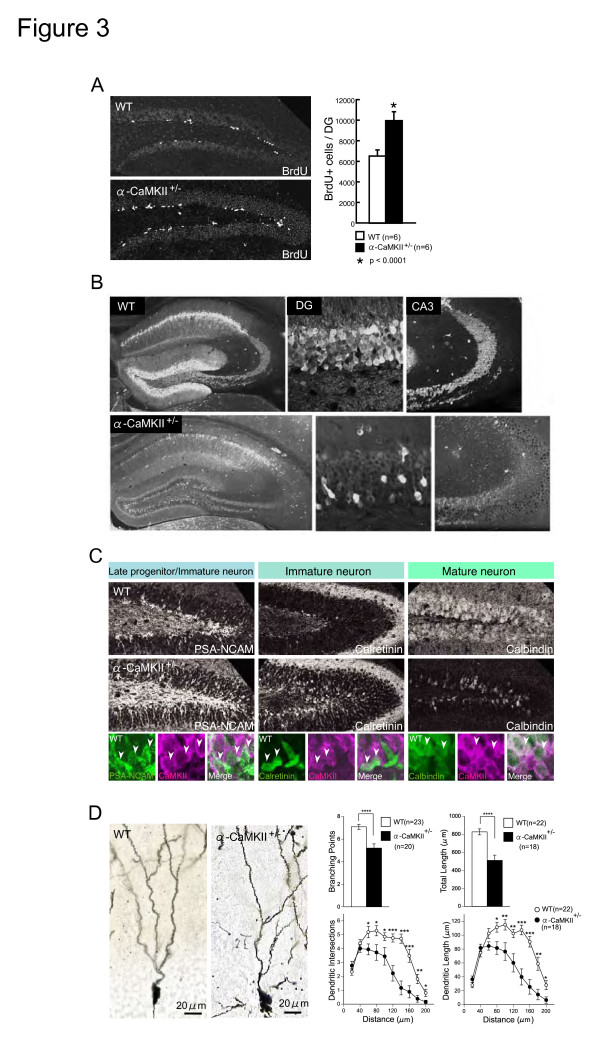
Immature DG of Alpha-CaMKII+/- Mice. (A) The number of BrdU-positive cells in the subgranular zone of the DG is increased in the alpha-CaMKII +/- mice at 7 weeks old, as observed 1 d after BrdU administration. The number of BrdU-positive cells within the DG was 52.8% higher (p = 0.00001) in the alpha-CaMKII +/- mice than in the wild-type mice. (B) In alpha-CaMKII+/- mice, the number of cells expressing calbindin (a mature-neuron marker) was decreased. (C) In alpha-CaMKII+/- mice, the number of cells expressing PSA-NCAM (a late-progenitor and immature-neuron marker) and calretinin (an immature-neuron marker) was markedly increased. CaMKII was co-expressed in a subset of PSA-NCAM-, calretinin-, and calbindin-expressing cells, indicated by the white arrowheads. For the analysis of expression of markers related to neurogenesis and differentiation, at least five mice were examined in each group. (D) Rapid Golgi staining showed that the number of Golgi-impregnated cells was decreased in the DG of alpha-CaMKII+/- mice (see Additional file 1, Figure S9) and that Golgi-impregnated cells in the DG of alpha-CaMKII+/- mice had less branching and shorter dendrites. * P < 0.05, ** P < 0.01, *** P < 0.001, **** P < 0.0001. Error bars indicate s.e.m.